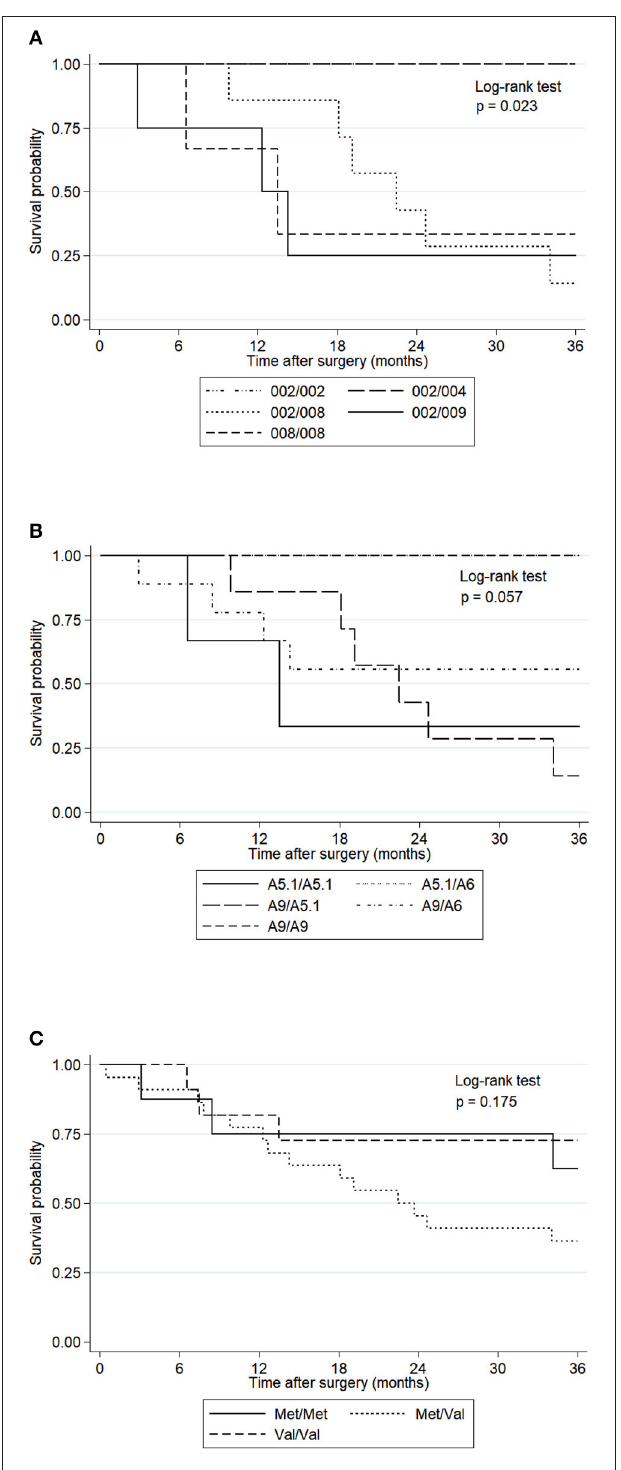
FIGURE 1 | Kaplan-Meier curves for overall survival of GC patients with tumors at III and IV TNM staging, according to MICA-sequence, MICA-STR and MICA-129 genotype. The p -values were calculated by the Log-rank test. (A) The survival probability of GC patients with MICA*002/002 ( n = 4) and MICA*002/004 ( n = 4) alleles were significantly higher than that of